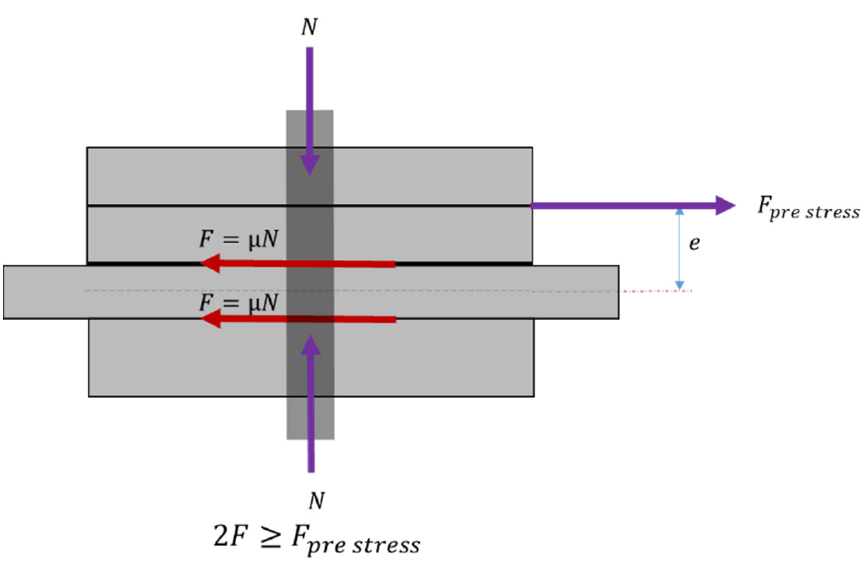
Figure 17. Free body diagram of the clamp and retrofit to determine the required friction force from the known pre-stress force.